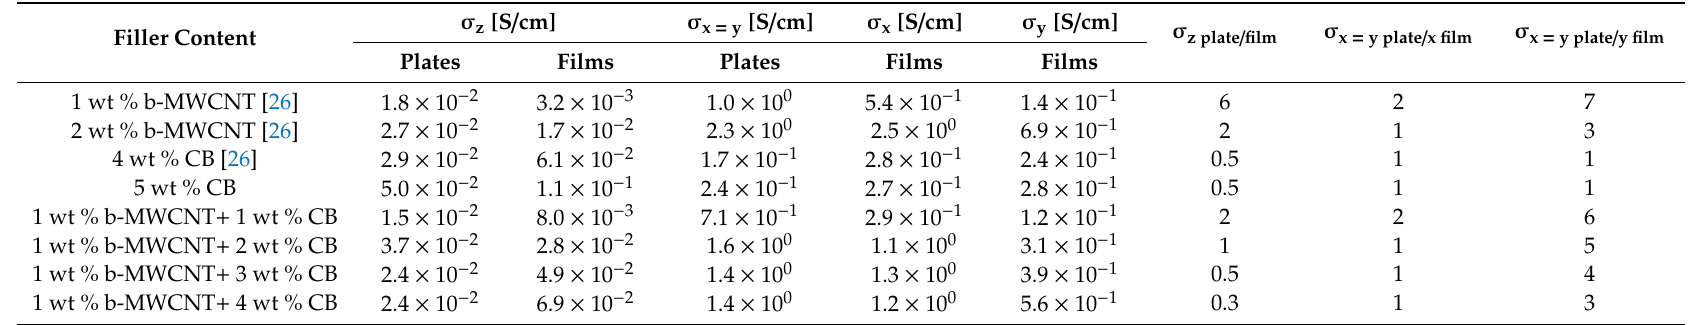
Table 1. Comparison of the electrical conductivities of laboratory-scale PVDF1 / carbon filler composites shaped to plates (thickness 0.3 mm) and extruded films (thickness 0.1 mm, film extrusion temperature of 225 ◦ C, take-o ff velocity at 2.5 m / min) and conductivity quotients σ plate / film in x = y (for plates) or x, y (for films), and z